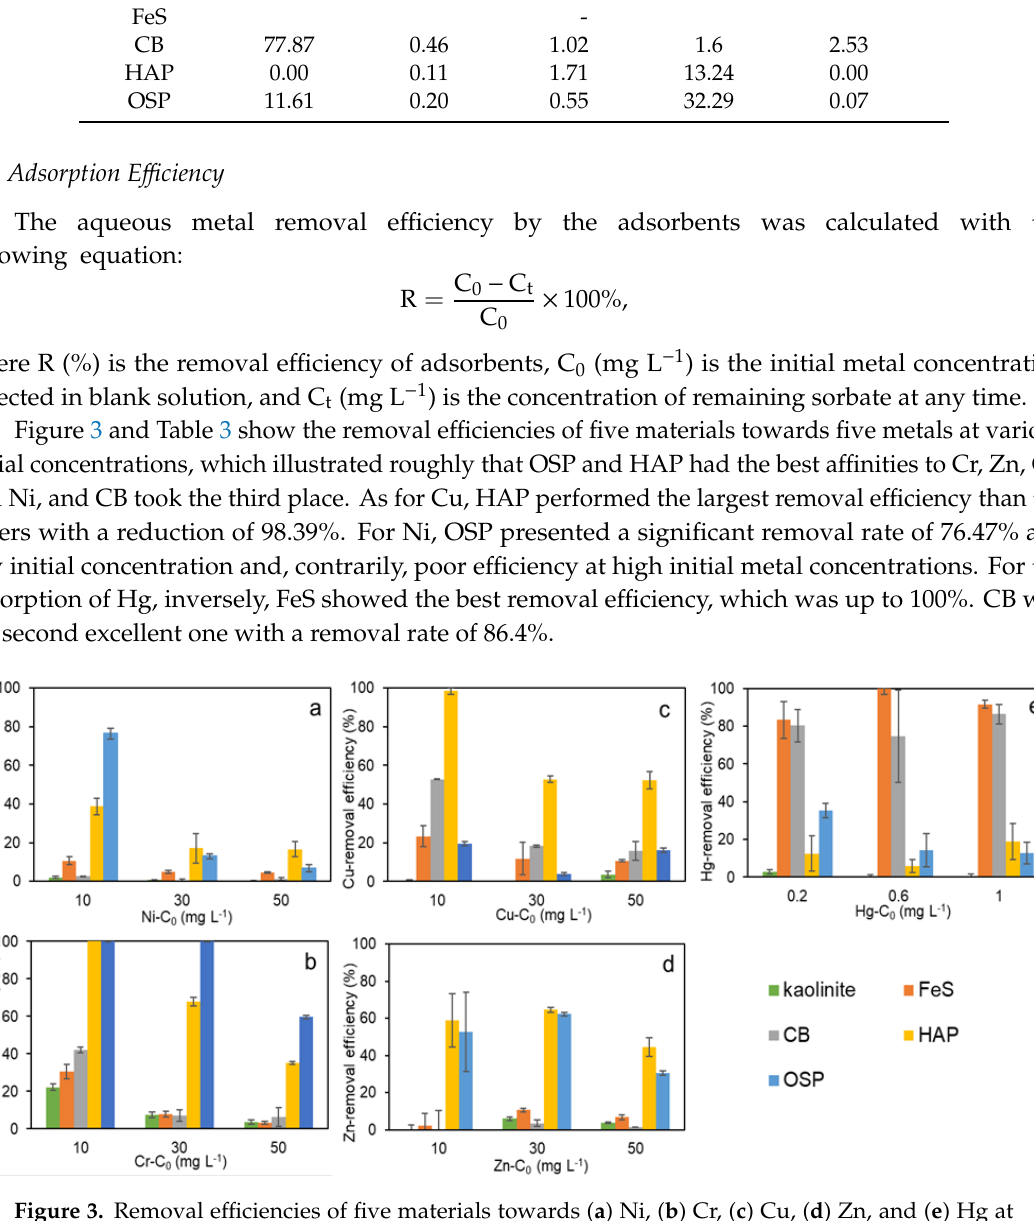
Table 3. Removal efficiencies (in percentage) of five adsorbents for five metals ( n = 3) .